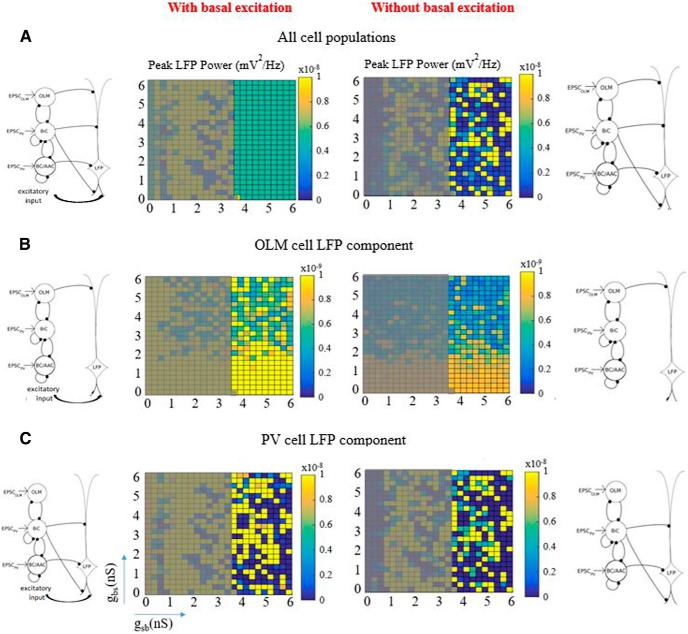
Peak power plots with and without basal excitation. The color plots represent peak power as described in Figure 7 and with a gray overlay as in Figure 9. Note that different color resolutions are used here to facilitate comparison for particular cell populations (i.e., any row). With and without basal excitation is shown on the left and right columns, respectively. Top, All cell populations. Middle, OLM cell LFP component. Bottom, PV cell LFP component.